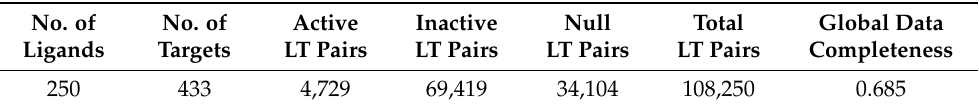
Table 2. Global data completeness of PK dataset